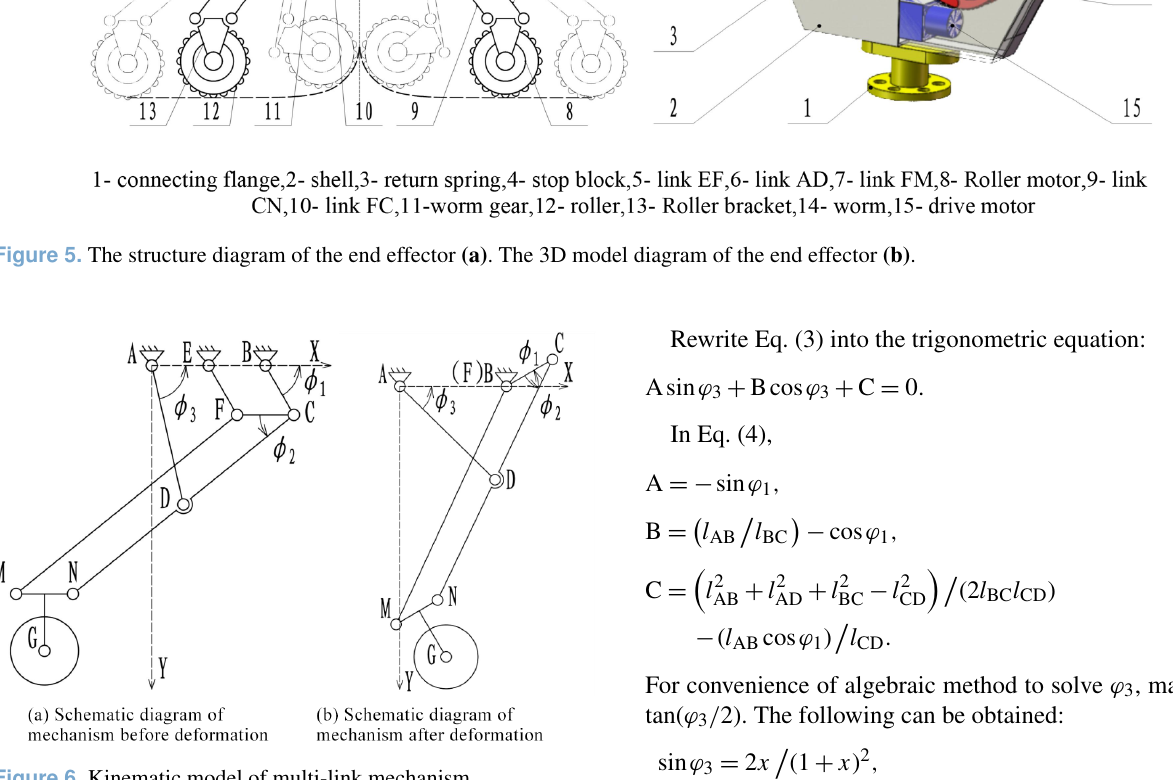
Figure 6. Kinematic model of multi-link